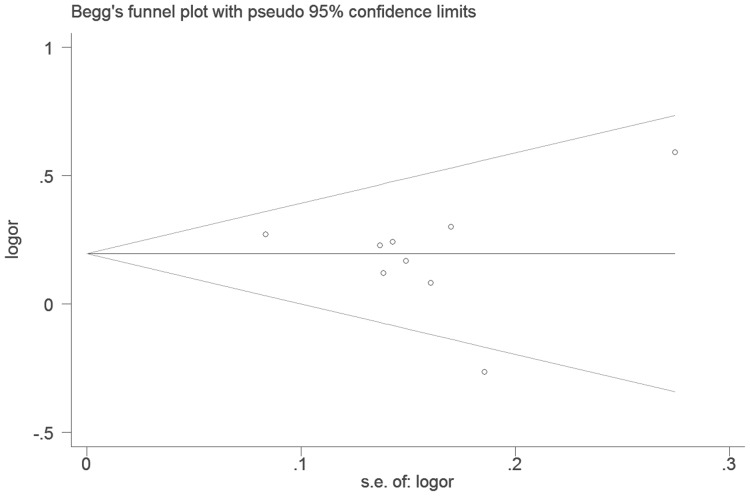
Begg's funnel plot of publication bias for EGF +61G/A polymorphism (a versus A).Plots are shown with pseudo 95% confidence limits. s.e., standard error.